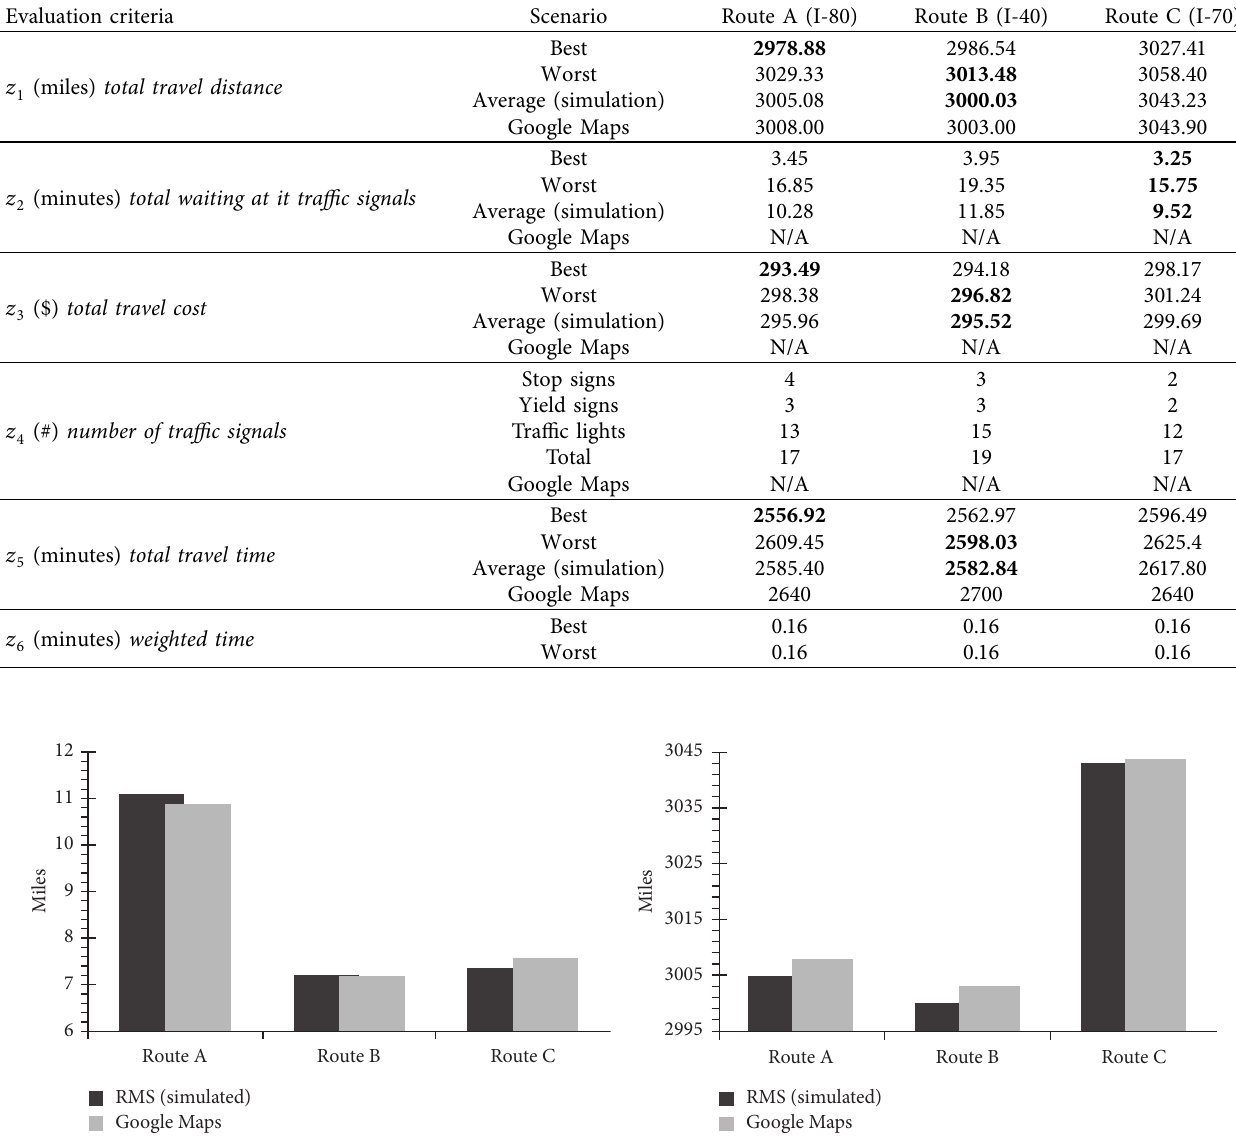
Table 7: Multiple criteria evaluation of long-distance routes.